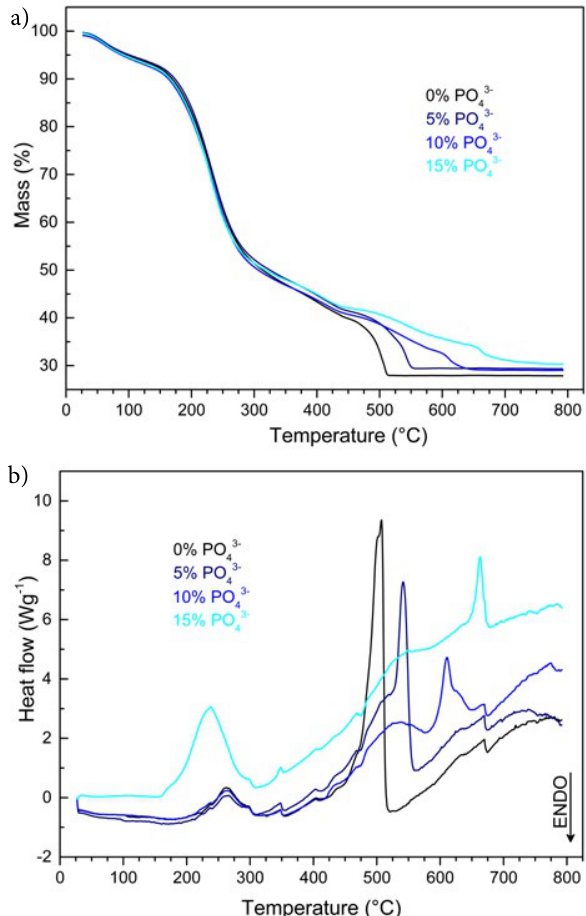
Figure 2. A comparison of (a) TG and (b) DSC curves of doped and undoped